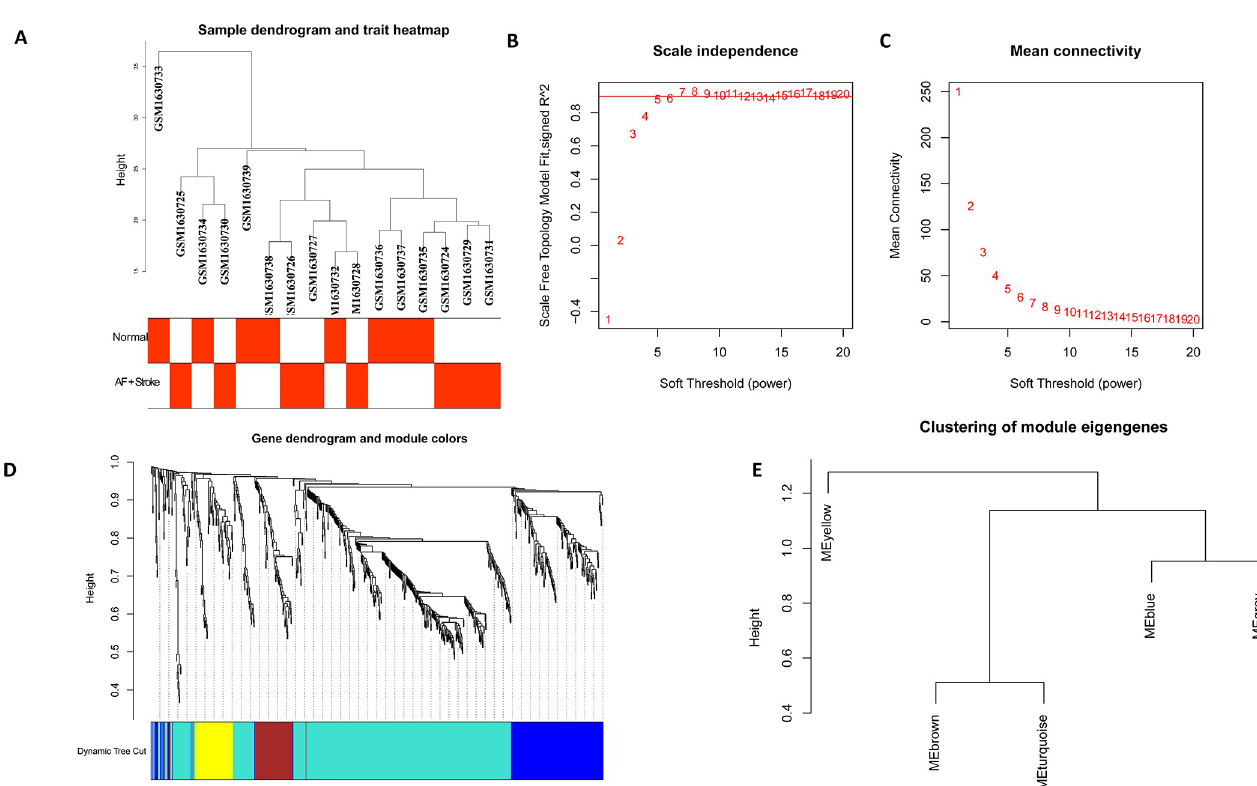
Fig 4. Sample clustering and network construction of the weighted co-expressed genes. Clustering dendrogram of 8 AF without Stroke and 8 AF with Stroke (A). The color intensity was proportional to disease status (with or without Stroke). Analysis of the scale independence (B) and the mean connectivity (C) for various soft-thresholding powers. The soft-thresholding power of 5 was selected based on the scale-free topology criterion. Dendrogram clustered was based on a dissimilarity measure (1-TOM). Gene expression similarity is assessed by a pair-wise weighted correlation metric and clustered based on a topological overlap metric into modules. Each color below represents one co-expression module, and every branch stands for one gene (D). The cluster dendrogram of module eigengenes was demonstrated (E).